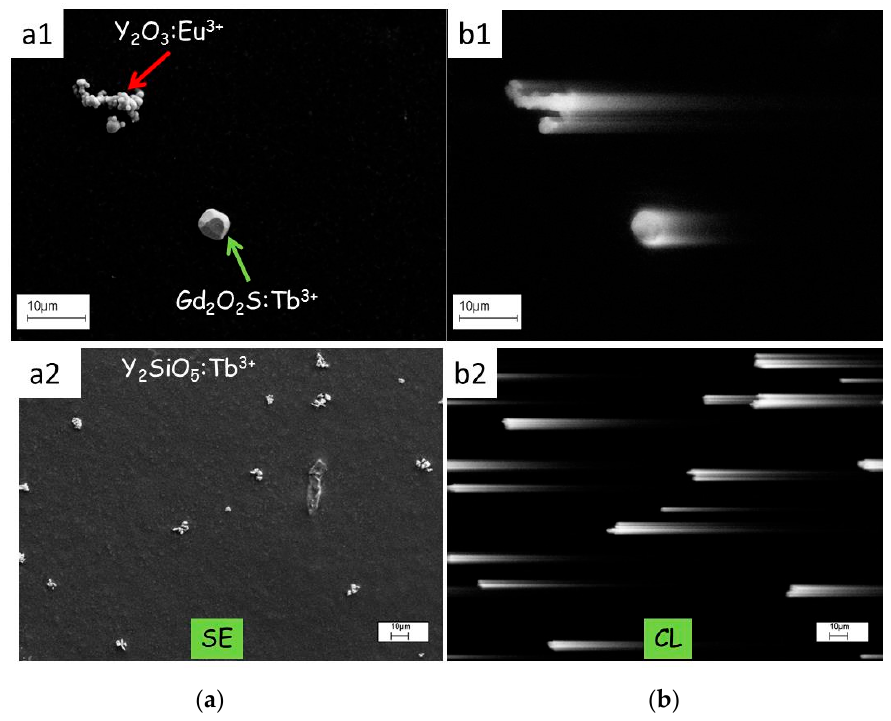
Figure 7. SE ‐ and CL ‐ images of phosphor particles on carbon substrate at 10 kV beam voltage: ( a1 ) SE ‐ image of a cluster of Y 2 O 3 :Eu 3+ particles and one Gd 2 O 2 S:Tb 3+ particle; ( a2 ) SE ‐ image of Y 2 SiO 5 :Tb 3+ particles; ( b1 ) CL ‐ image of same area as ( a1 ); and ( b2 ) CL ‐ image of same area as ( a2 ). The scanning rate for the CL ‐ images was 10.1 s/frame. One frame consisted of (1024 × 768) pixels.